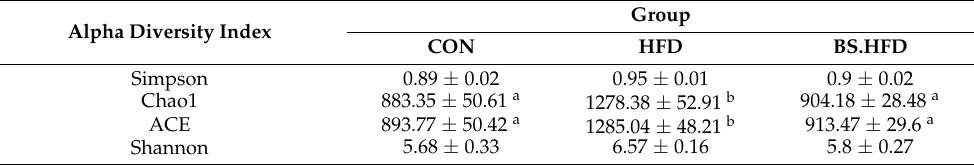
Table 4. Alpha diversity of the intestinal microbiota in C. idella .